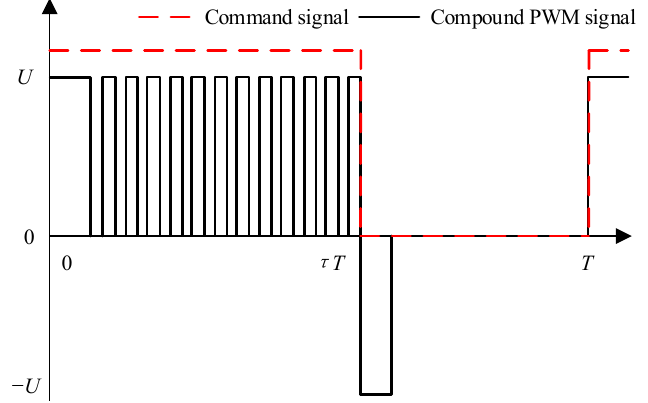
Figure 10. Schematic diagram of compound PWM control signal.